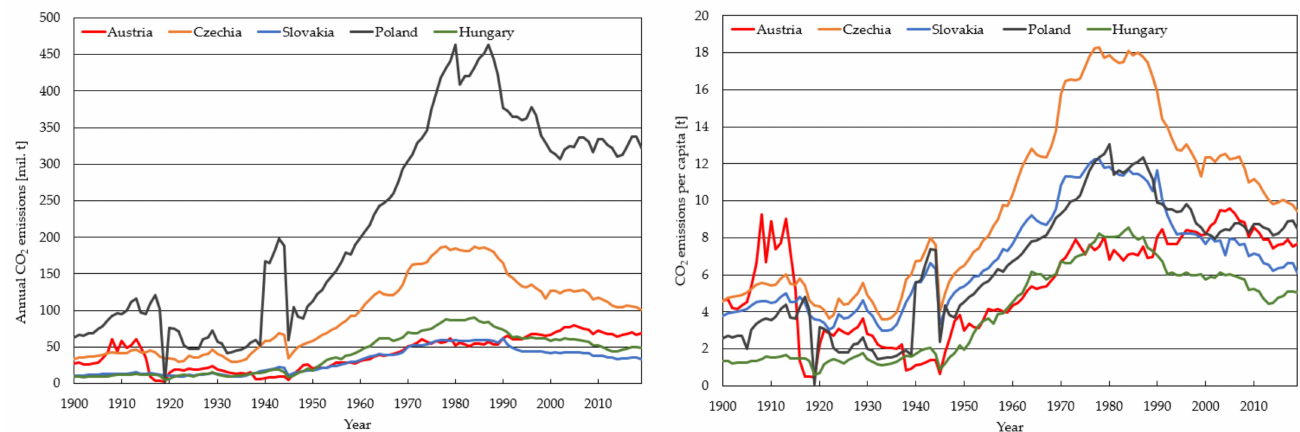
Figure 16. Historical development of total ( left ) and per capita ( right ) carbon dioxide emissions